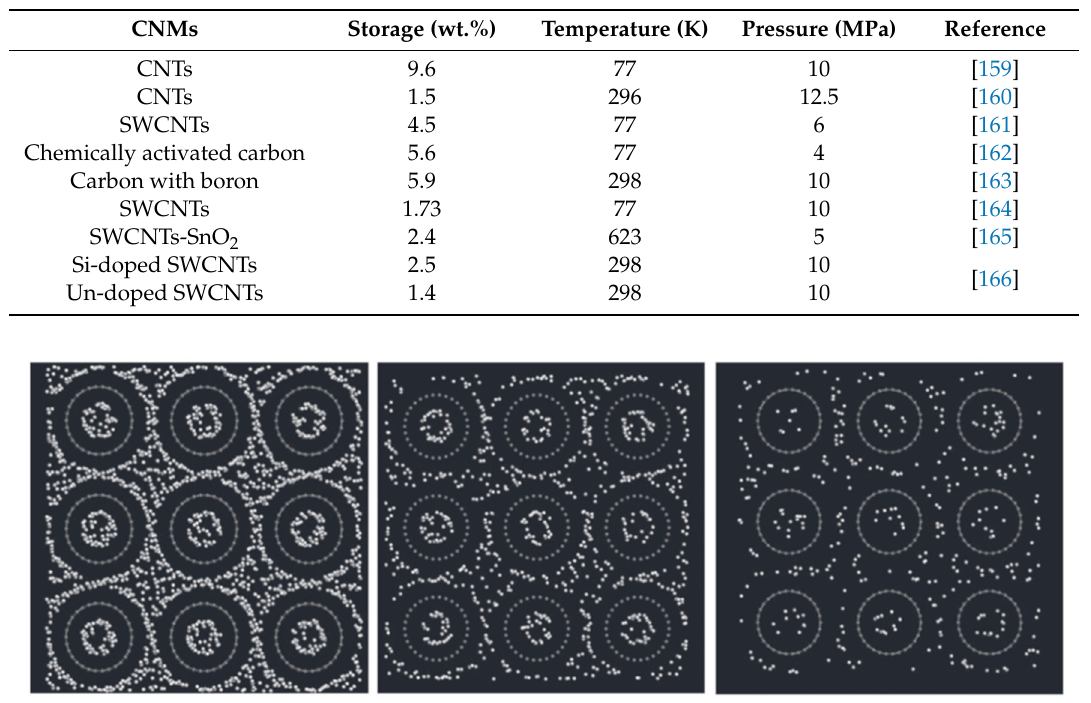
Figure 10. Hydrogen storage in nanotube bundles. Snapshots from grand canonical Monte Carlo simulations taken under 100 Bar pressure at 77 K (left), 175 K (middle), and 293 K (right) Table 9. Hydrogen storage efficiency of different kinds of CNMs at different conditions.